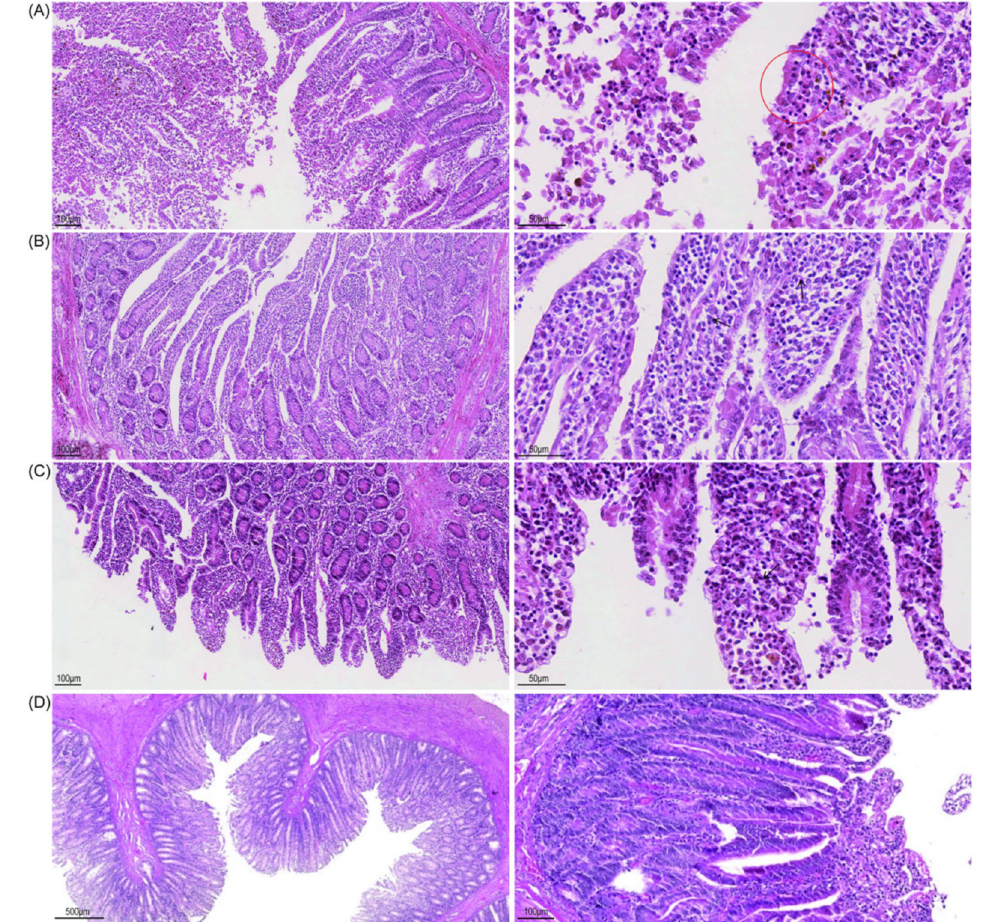
Figure 7. Histopathology of calf small-intestine sections. ( A ) Representative section of lesion tissue in the challenge control group; red circles show apoptosis and necrosis (10 × 10). ( B ) BVDV − 1 immunization group (10 × 10). ( C ) BoHV − 1 gE/E2 − Linker − E2 + immunization group (10 × 10). ( D ) Representative section of normal lung tissue in the blank control group (10 ×